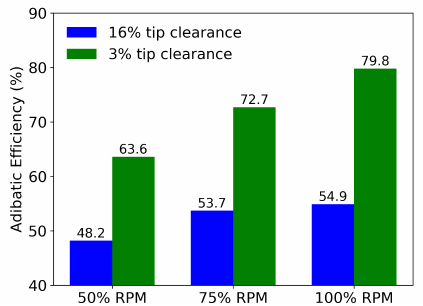
Figure 24. Predicted adiabatic efficiencies at different rotor speeds for two tip clearance